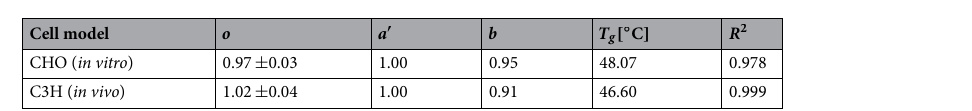
Table 1. Parameters of the TER model Eq. (17), obtained from CHO and C3H cell models 58,60 .